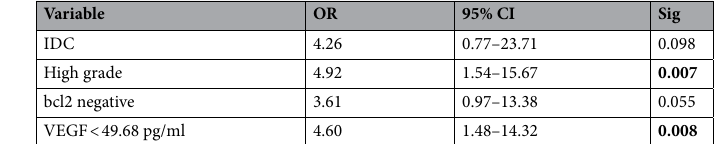
Table 4. Binary logistic regression (adjusted for age) for the relationship between analysed cytokines and clinicopathological characteristics with PD-L1. Variables entered in step 1: age, histology, grade, bcl2, HR status, ki-67 proliferation, VEGF, TNF-β, IL-15; − 2 Log likelihood = 77.83; R 2 (Cox and Snell) = 0.32; R 2 (Nagelkerke) = 0.43. Significant results are highlighted in bold. IDC, invasive ductal carcinoma.